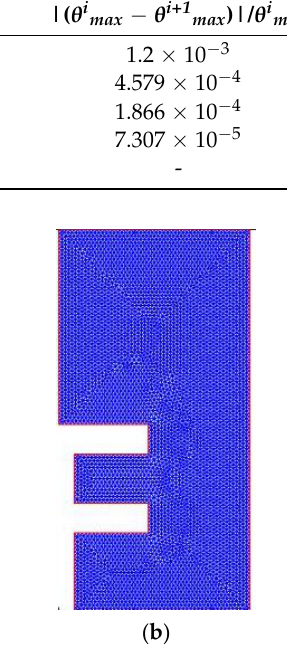
Figure 2. Triangular mesh used by FEM from MATLAB ® PDE toolbox: ( a ) coarse mesh with 1250 triangular elements; ( b ) symmetric half of the domain numerically solved during optimization process with a fine mesh of triangular elements.